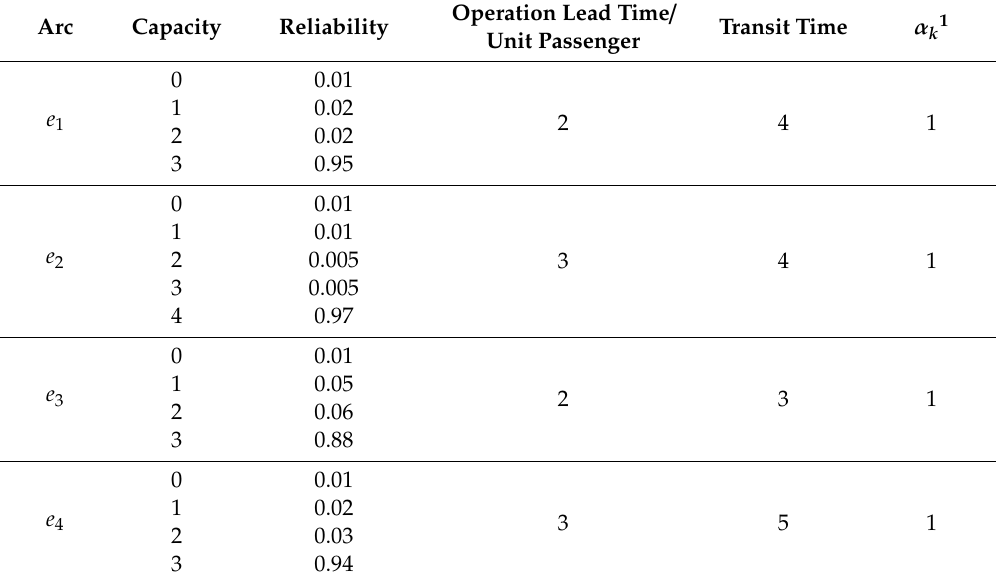
Table 5. Basic information of each arc.